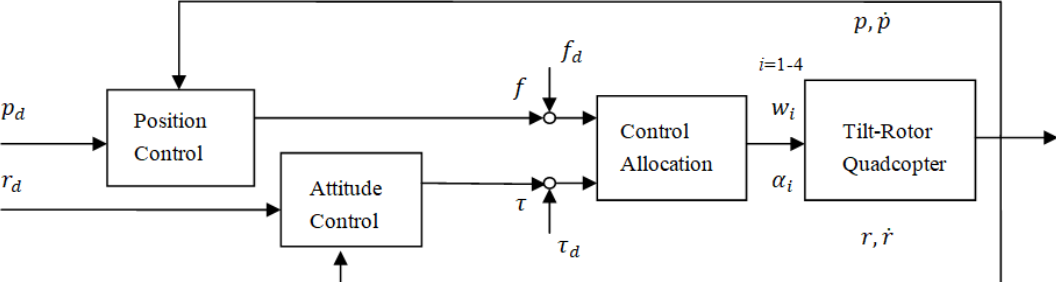
Figure 2. The TRQ control